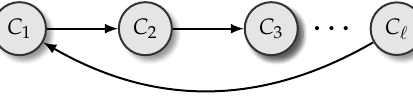
Figure 1. The basic cyclic